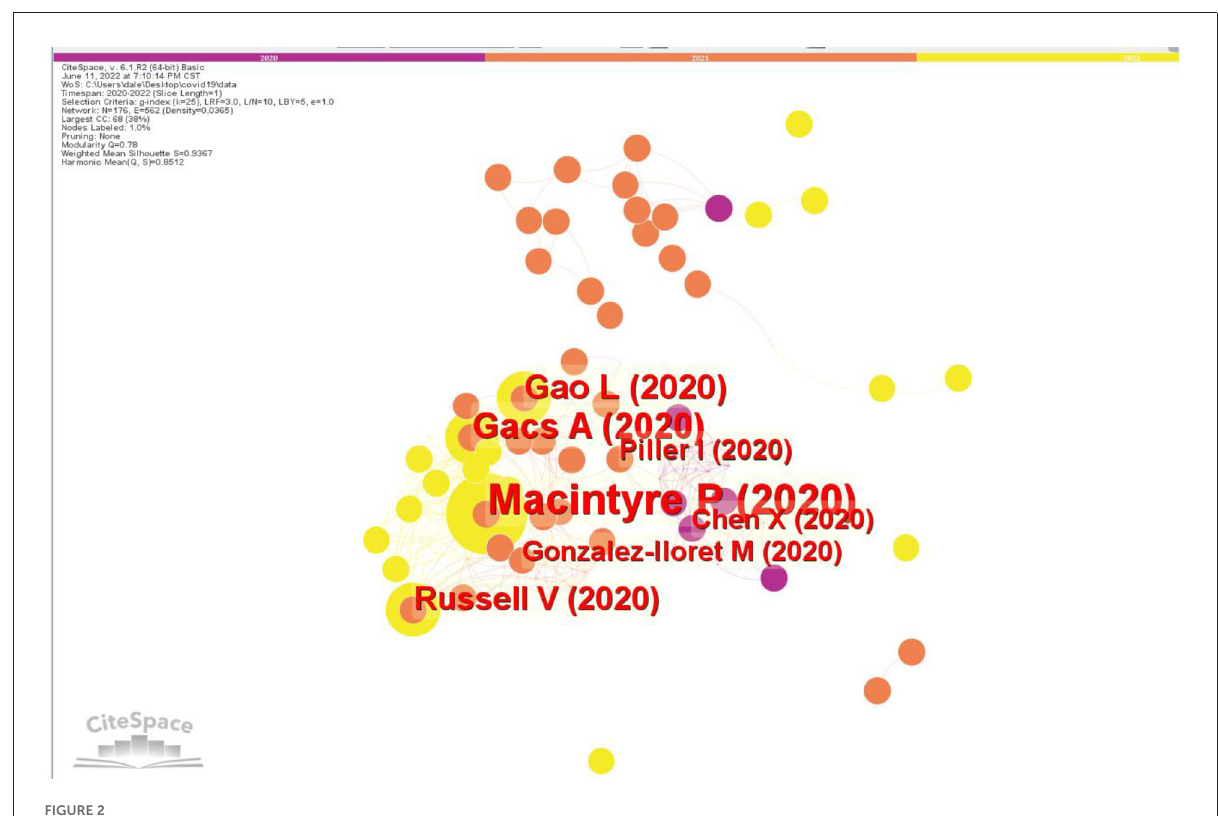
FIGURE2 Critical articles in linguistic research on